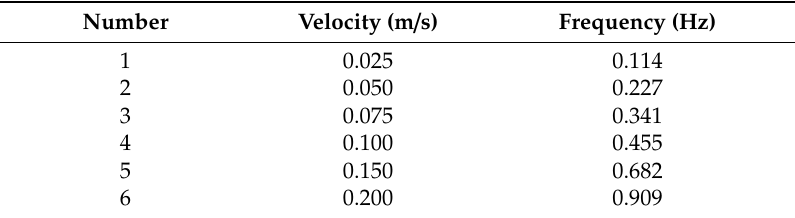
Table 4. Velocity conditions of test for force-velocity